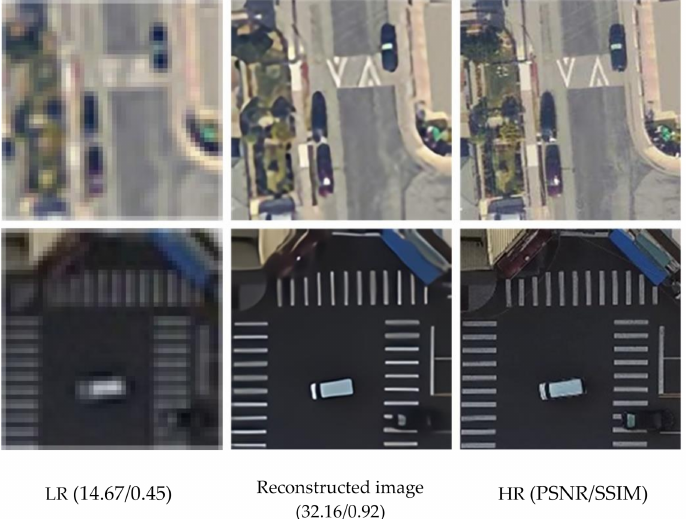
Figure 11. Object reconstruction using SRCGAN-RFA-YOLO having a scale factor of 8 from Draper Satellite Image Chronology ( top ) and VAID dataset ( bottom ) using the parameters learned from the Potsdam dataset.